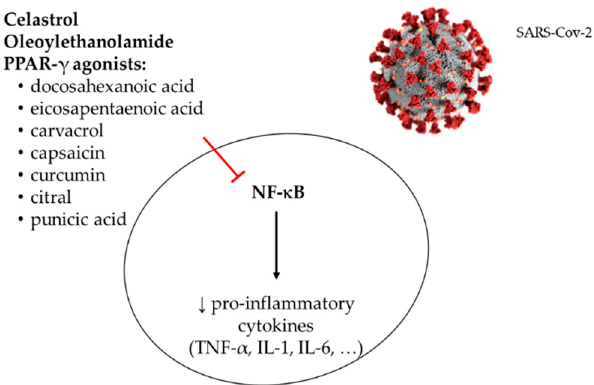
Figure 3. Anti-inflammatory effect of bioactive compounds present in foodstuffs. PPAR: peroxisome proliferator-activated receptor, TNF: tumor necrosis factor, IL: interleukin, ↓ : decrease.